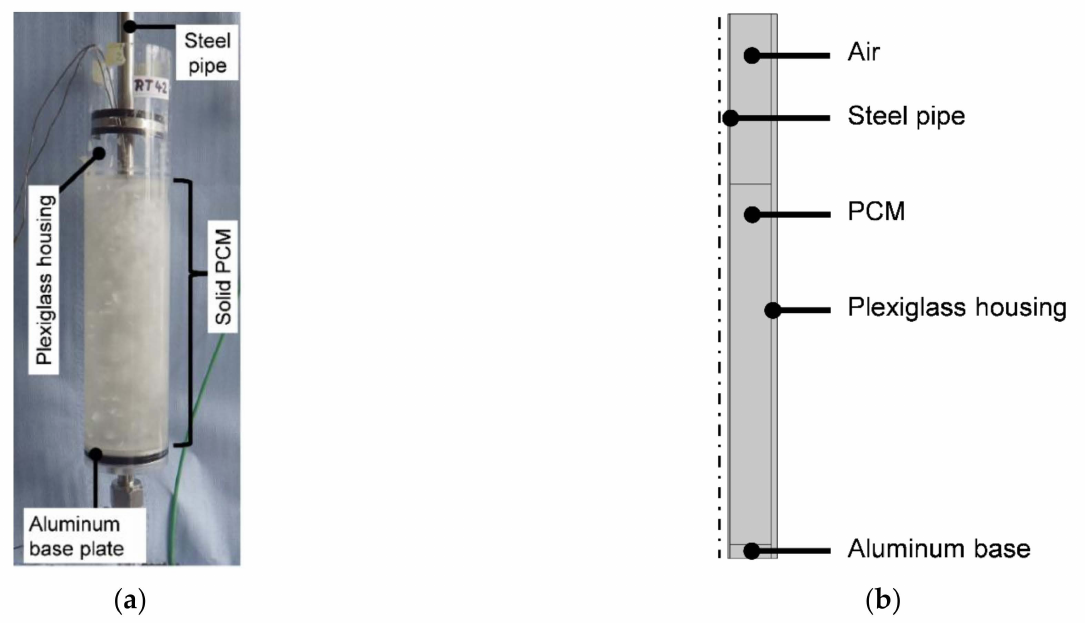
Figure 2. ( a ) Setup of the laboratory experiment. ( b ) Geometry of the two-dimensional and rotation- ally symmetric numerical